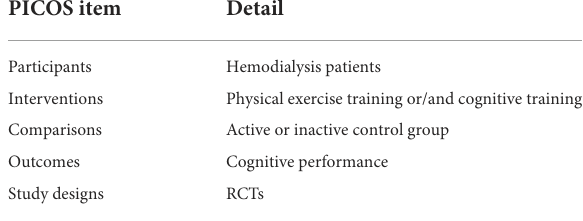
TABLE 1 “PICOS” items (participants, intervention, comparisons, outcomes, study designs) used to select keywords. PICOS